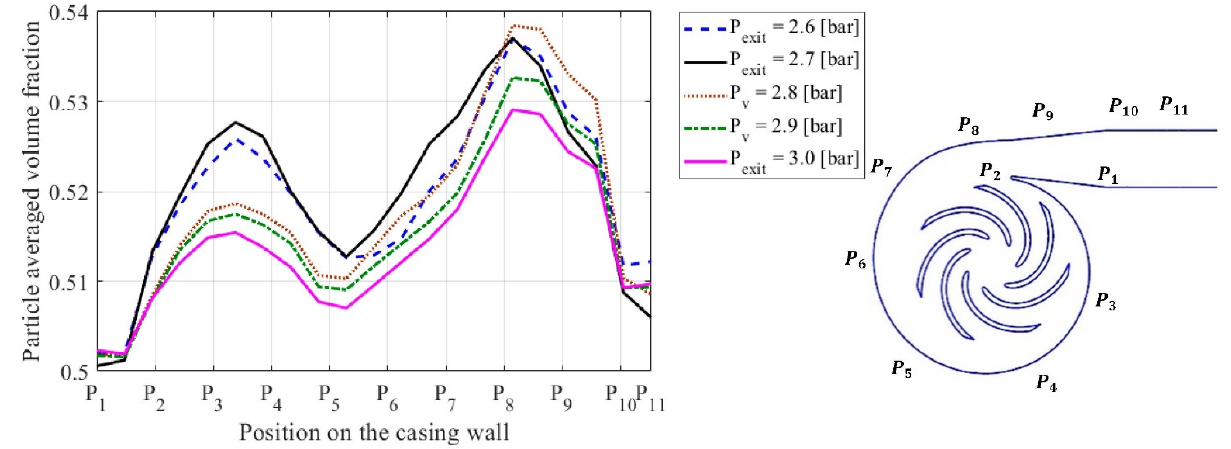
Figure 16. Variation of erosion density rate on the blade walls with different solid particles size and distribution values.